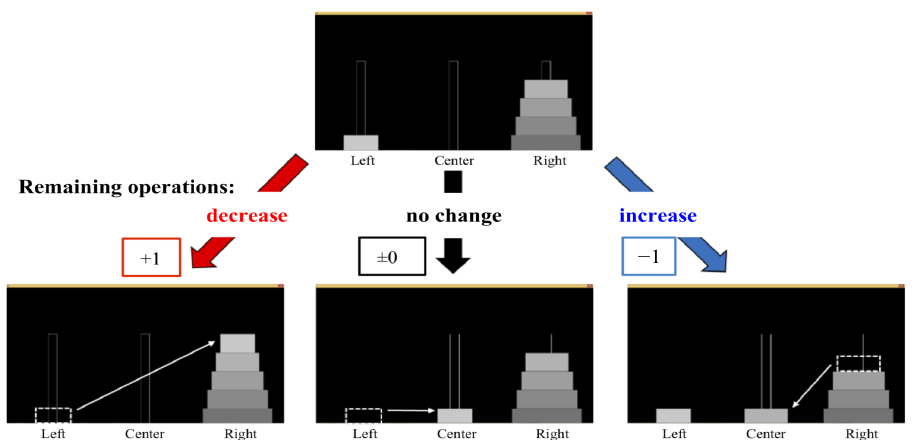
Figure 6. The evaluation method for the degree of progress.